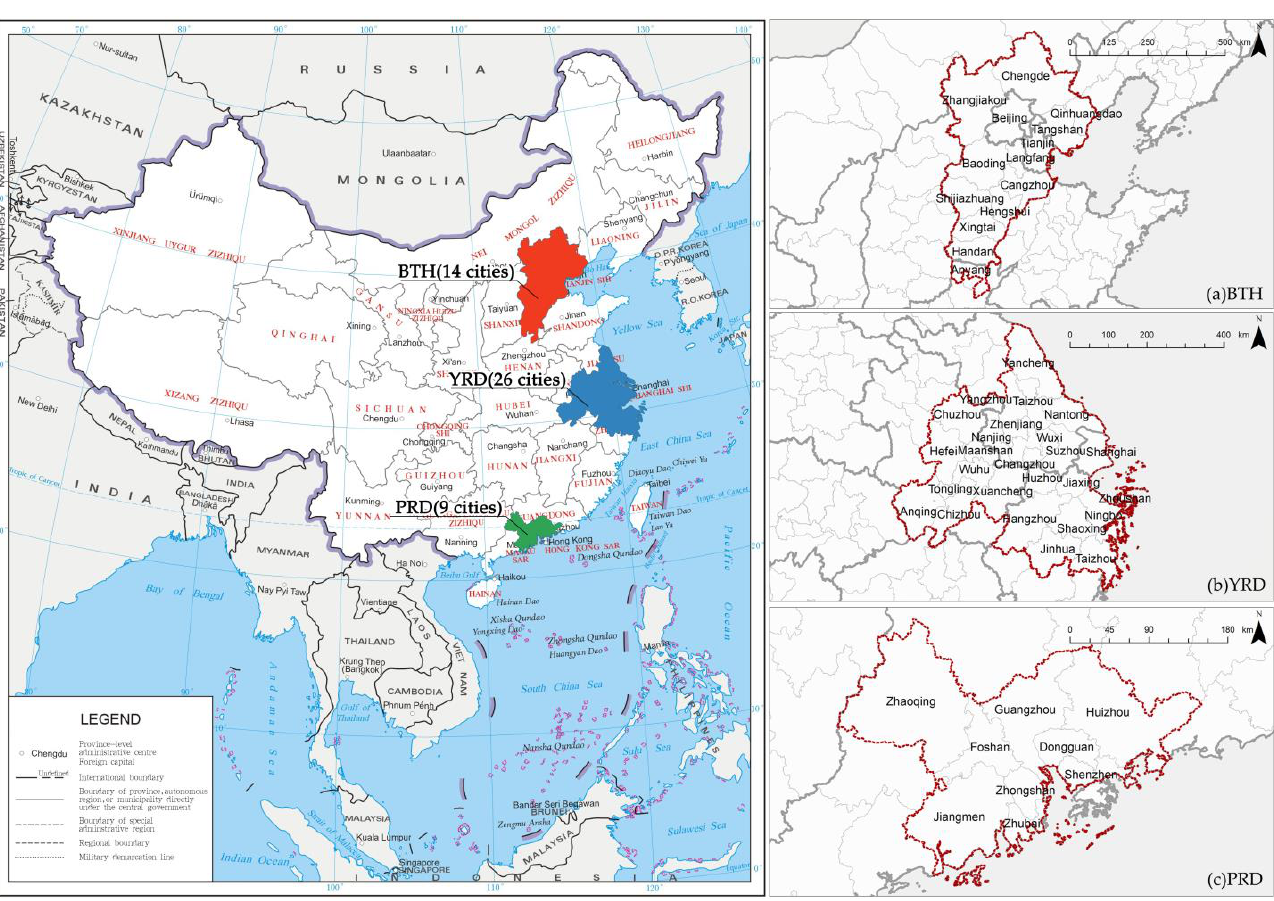
Figure 1. Location of three major urban agglomerations of China.